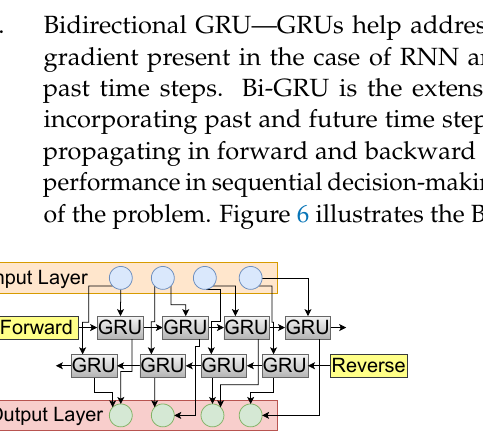
Figure 5. GRU unit.